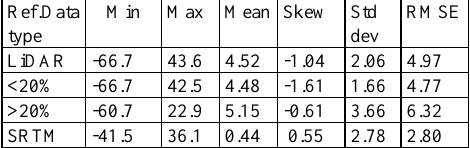
Table 2. Elevation difference statistics for Bihar test